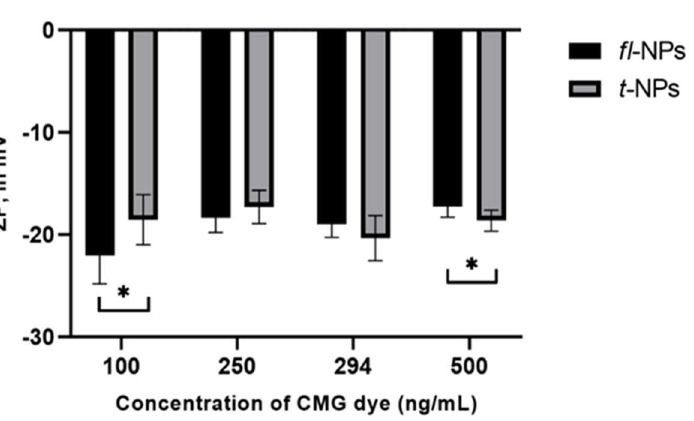
Figure 6 . ZP measurement of fluorescent and total NPs originating from JAr cells labeled with different concentrations of CMG dye (100, 250, 294 and 500 ng/mL respectively). The ZP values for fl and t -NPs at the lowest and highest concentrations of CMG were significantly different ( p ≤ 0.05) than the corresponding t -NPs at 100 and 500 ng/mL of CMG dye. Thus, were marked with an asterisk (*) symbol. JAr EVs measured in fluorescent and scatter modes of NTA. EVs were diluted